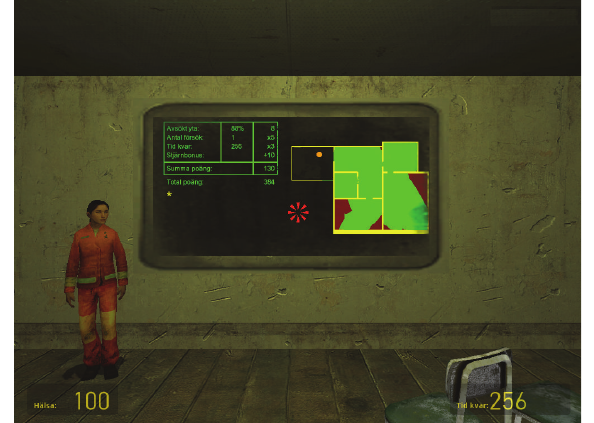
Figure 4: The debriefing room. The board presents achieved score and an overview of the premises. The bright fields in the map represent areas visited by the